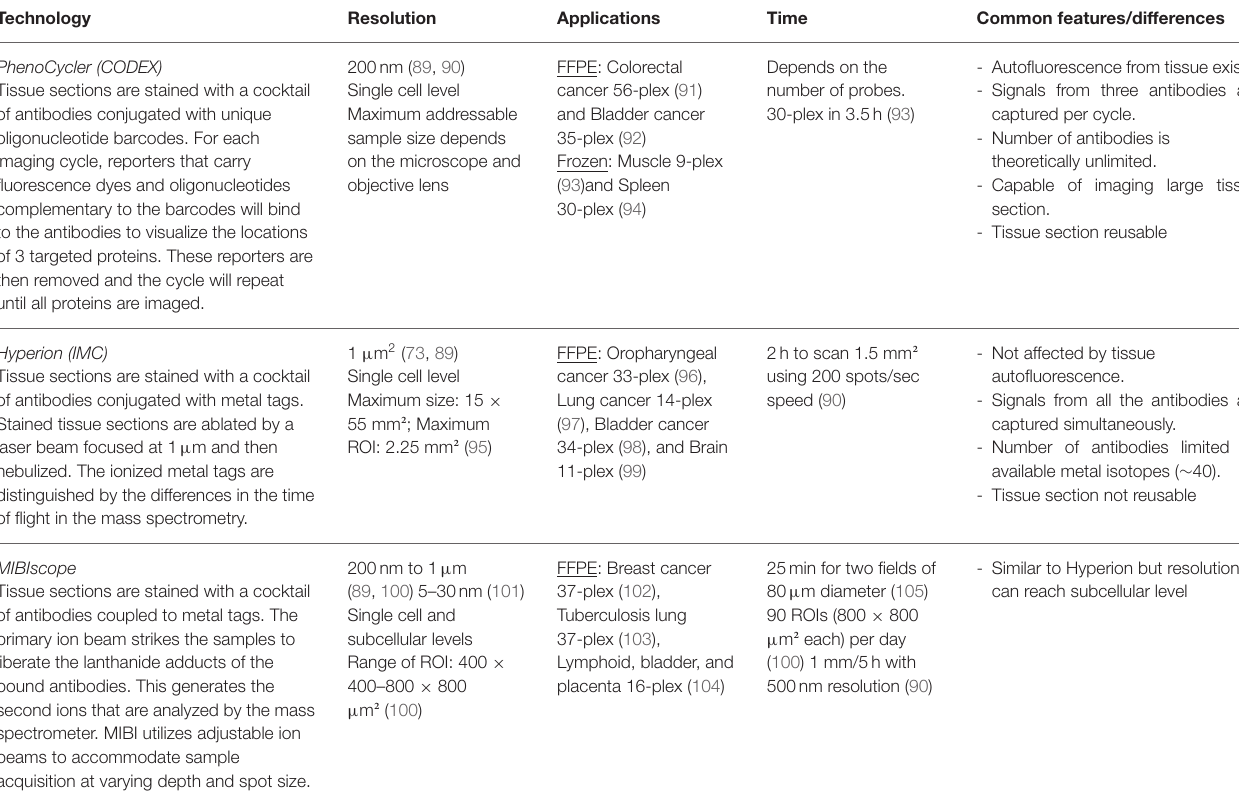
TABLE 2 | Spatial protein expression technologies. Technology Resolution Applications Time Common